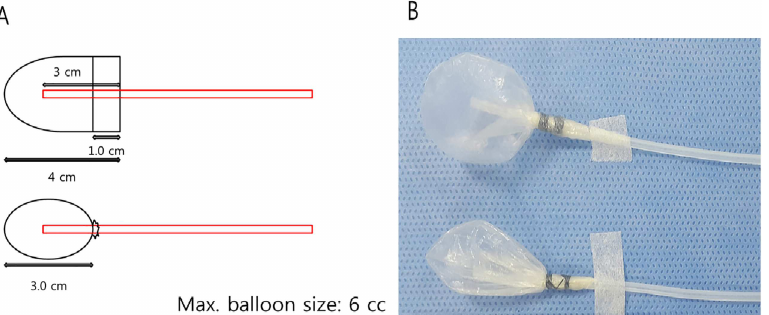
Fig 2. The intra-gastric balloon. (A) A polyethylene bag was made by using a 3 rd finger-tipof poly-glove (Hanjin,Seoul, Korea). Maximal diameter is 3 cm. (B) The maximum volume of balloonwas 6 mL and air was injectedinto the balloonfrom one of the balloontubes with the other side balloontube closed to allow placementof the balloonwithin the stomach, after which the balloontubes were immediately openedto the